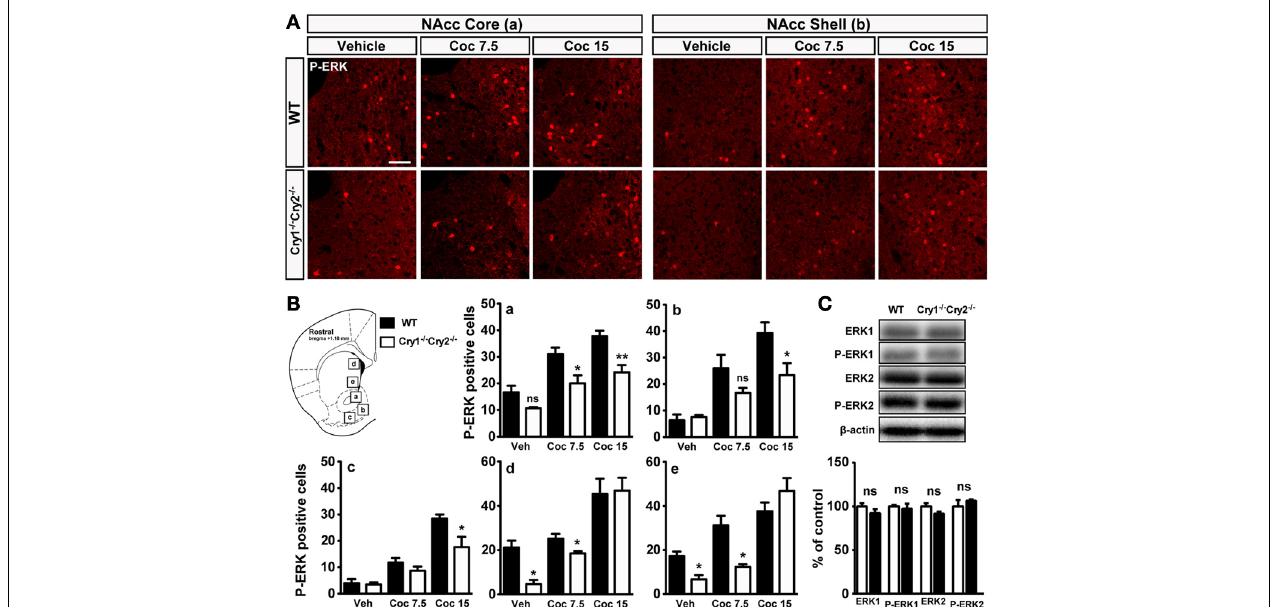
neurons in NAcc core (a), NAcc medial shell (b), NAcc ventral shell (c), dorso-medial striatum (d), and ventro-medial striatum (e). Data (means ± sem) were analyzed using an unpaired Student’s t -test: ∗ p < 0 . 05, ∗∗ p < 0 . 01. (C) Quantification of ERK1 and ERK2 expression levels in wild type (WT) ( n = 6) and Cry1 − / − Cry2 − / − mice ( n = 6) (means ±